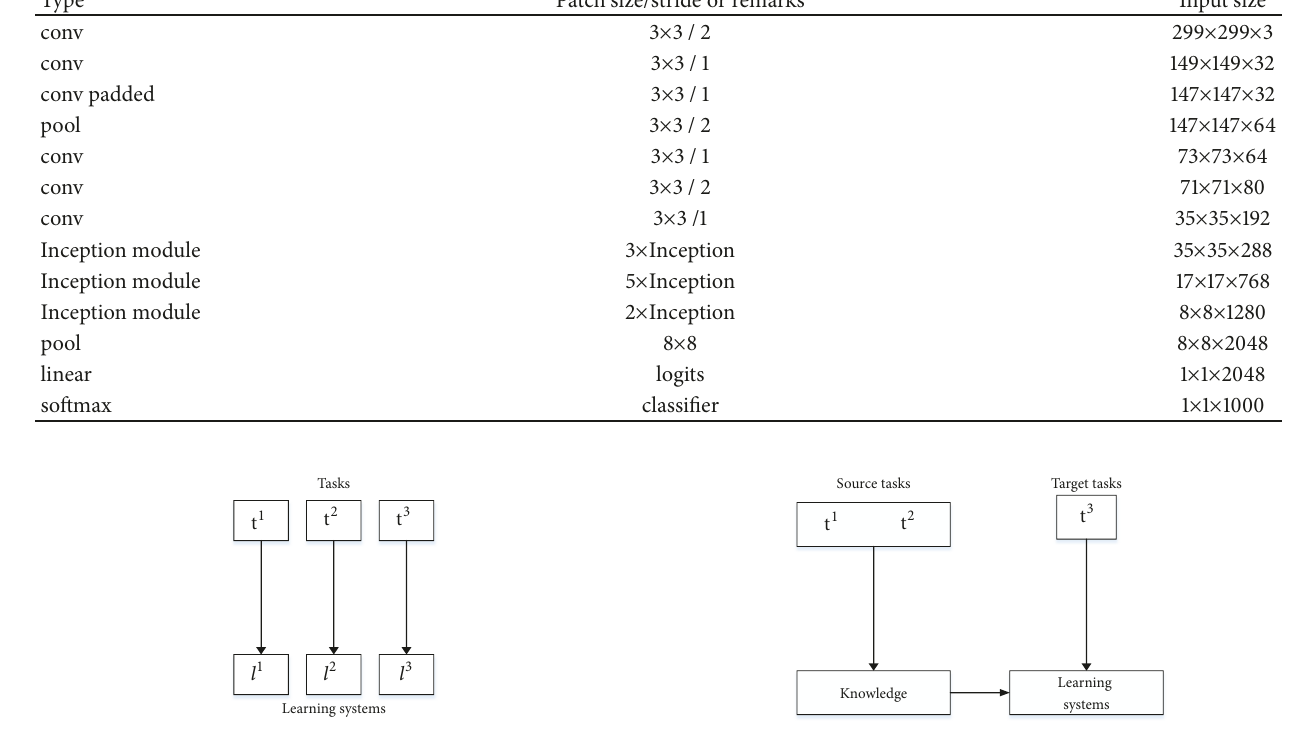
Figure 5: Traditional machine learning. Figure 6: Transfer